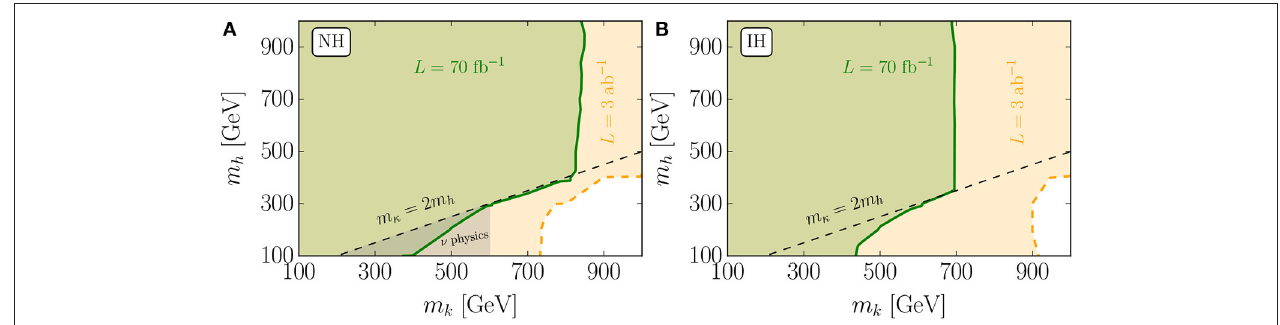
FIGURE 41 | Projection of sensitivities at the LHC in the m k - m h plane: (A) the NH benchmark with g 11,22 0.1, g 12,13,33 0.001, f 12,13 0.01 and = = = ±± ± f 23 f 13 0.02; (B) the IH benchmark with g 11,23 0.1, g 12,22,13,33 0.0001, f 12 0.1 and f 23 0.01. For both benchmarks, the trilinear coupling is chosen = = = = − = = to be µ ZB 5 min ( m k , m h ). The gray shaded region in the left panel is excluded by low energy experiments. The green and orange regions are excluded by = ±± ± future experiments with an integrated luminosity of 70 fb − 1 and 3 ab − 1 respectively [525].